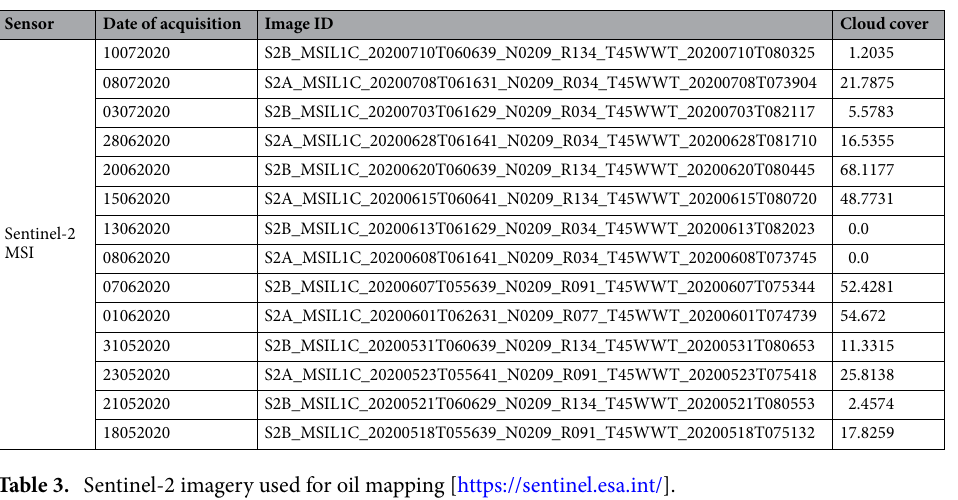
Table 3. Sentinel-2 imagery used for oil mapping [https ://senti